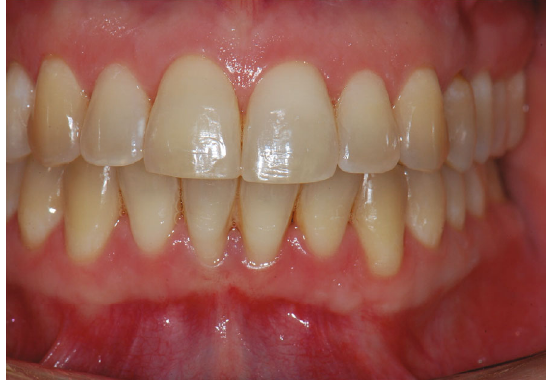
Figure 9: Postoperative front view at the three-year follow-up showing an excellent color match of the tissues.